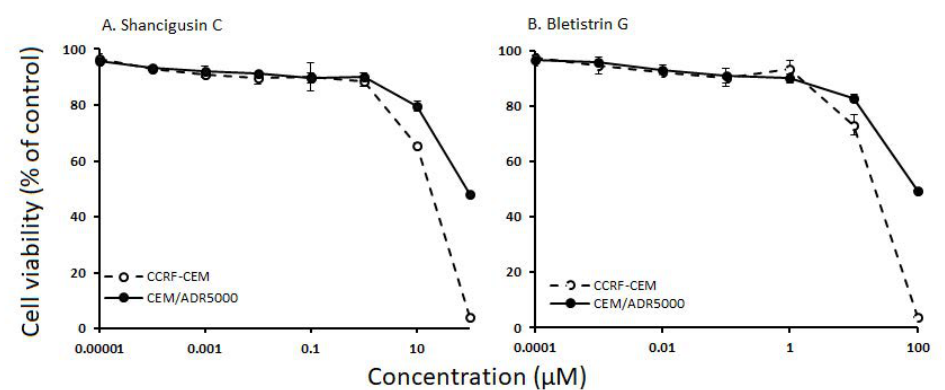
Figure 3. Cytotoxicity of shancigusin C ( 1 ) and bletistrin G ( 2 ) towards human sensitive CCRF-CEM and multidrug-resistant CEM/ADR5000 leukemia